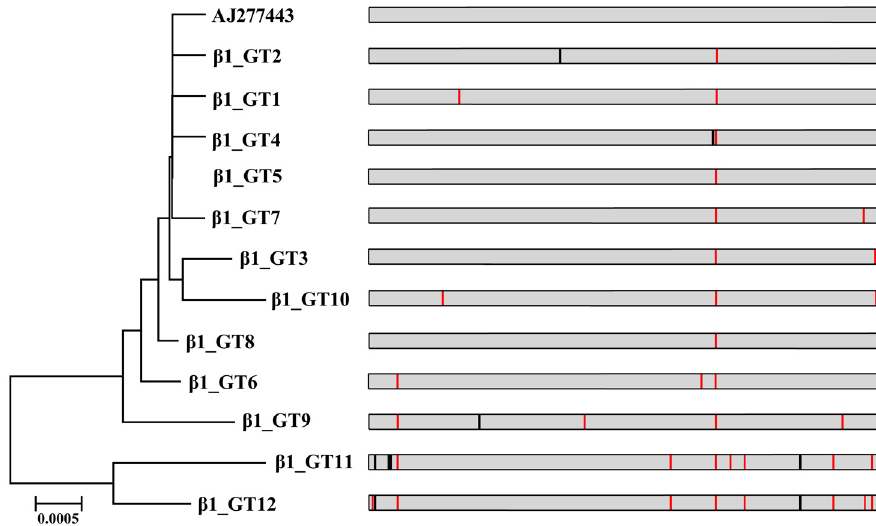
Fig 2. Neighbor-joining tree of 12 genotypes of eae genes among the 43 eae - β 1 strains and one reference sequence (AJ277443). Polymorphic sites in the intimin alleles were illustrated. Black vertical lines indicate synonymous polymorphic sites and red vertical lines represent non-synonymous polymorphic sites. GT: genotype.